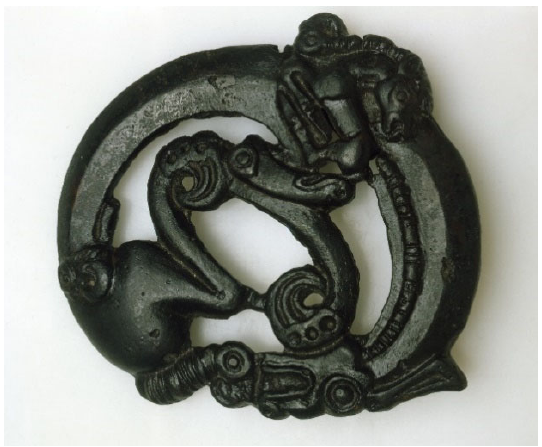
Figure 8. Bridle plaque in the form of a coiled feline (SHM inv. no. Kp.1895 ‐ 10/2); cast bronze; Kulakovsky Tumulus 2, Crimean Peninsula; early 5th century BC. [Image is used from www.hermitagemuseum.org (accessed 9 November 2022), courtesy of the State Hermitage Museum, St. Petersburg, Russia].